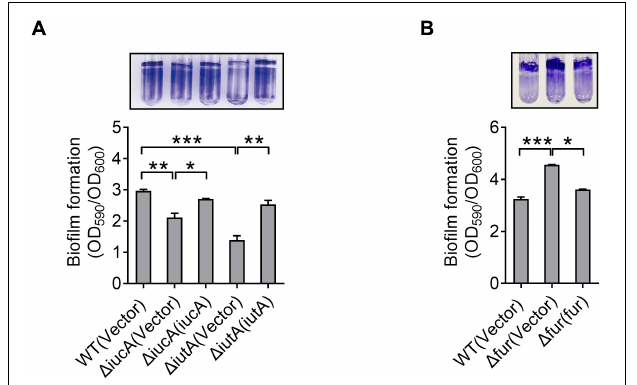
FIGURE 4 | Aerobactin-mediated iron acquisition influences biofilm formation. (A,B) Effect of aerobactin system (A) and Fur (B) on biofilm formation in iron-limiting media. Saturated bacterial cultures were diluted 100-fold in fresh M9G minimal medium. After vertical incubation for 3 days with shaking at 150 rpm in 26 ◦ C, biofilm formation of the strains was determined by crystal violet staining and quantified using optical density measurement. Statistical analyses for the rest of the assays were performed using unpaired two-tailed Student’s t -test. Data represent the mean ± SEM of three biological replicates, each of which was performed with three technical replicates. * p < 0.05; ** p < 0.01; *** p < 0.001.